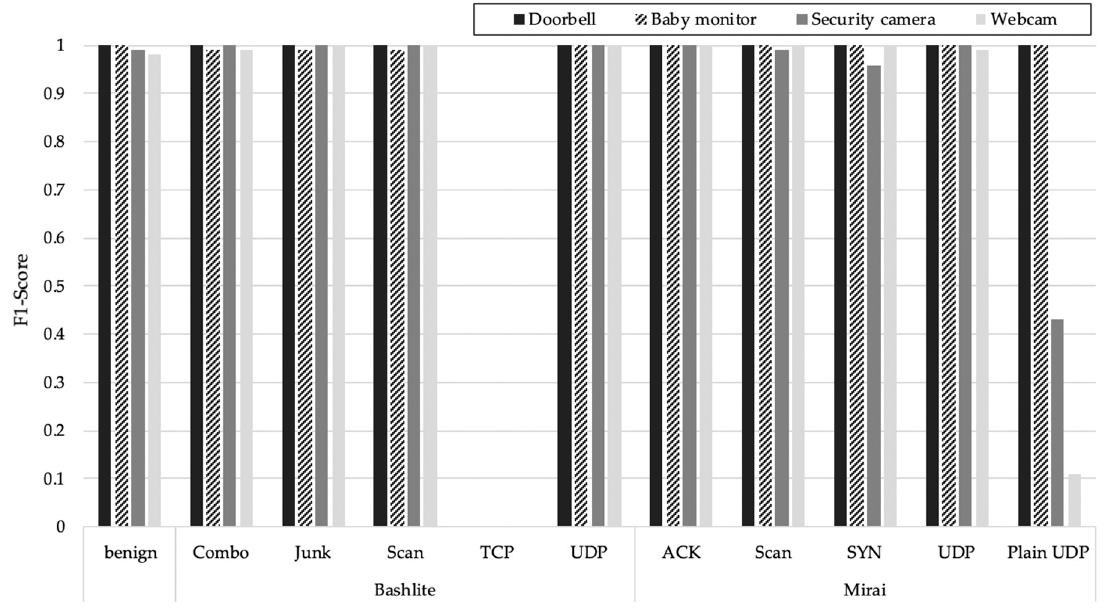
Figure 5. F1-score of each specific attack in the CNN.